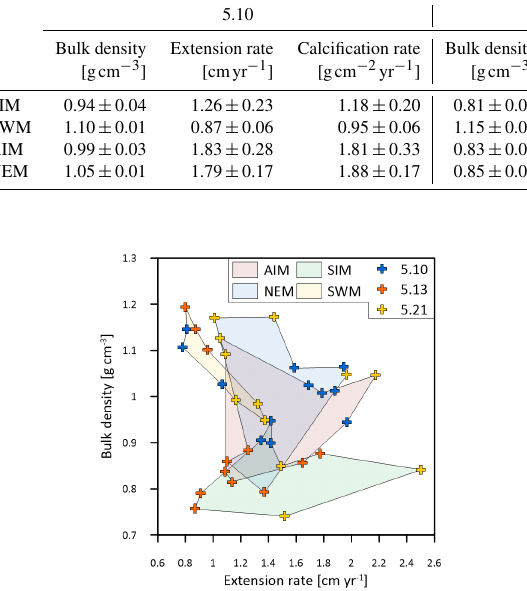
Figure 7. Multi-year monthly means in extension rate versus skele- tal bulk density of the three corals from Masirah Island (blue, or- ange, yellow). The coloured shaded polygons combine monthly data that belong to the same season. Seasonal abbreviations: NEM (northeast monsoon), SIM (spring intermonsoon), SWM (southwest monsoon), AIM (autumn intermonsoon).